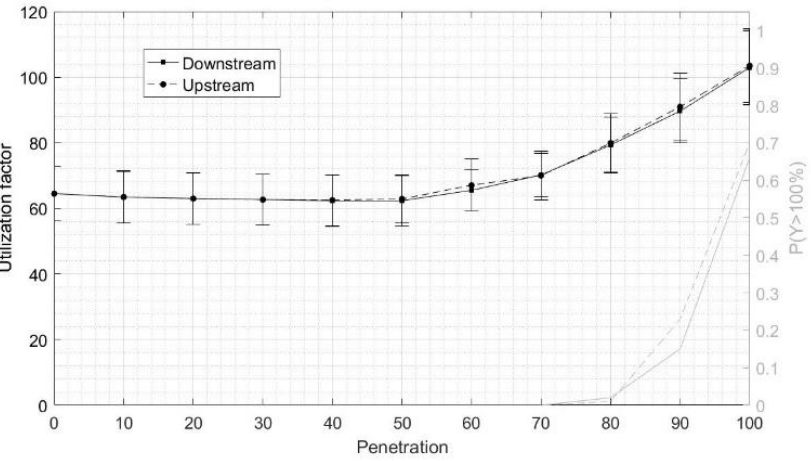
Figure 7. Feeder 4 CDFs results: utilization capacity level.